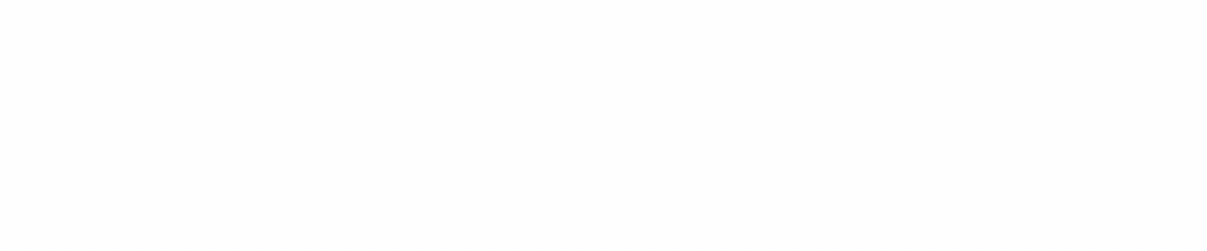
inin-2 expression in dy/dy mice appears to result in